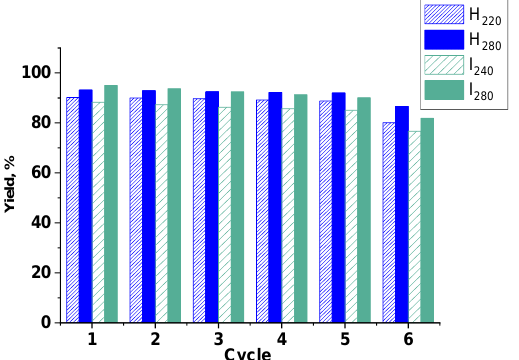
Figure 12. The results of recycling catalytic experiments for Ni NPs@PPP prepared by the heat-up approach at 220 and 280 °C (H 220 and H 280 ) and by the injection method at 240 and 280 °C (I 240 and I 280 ).